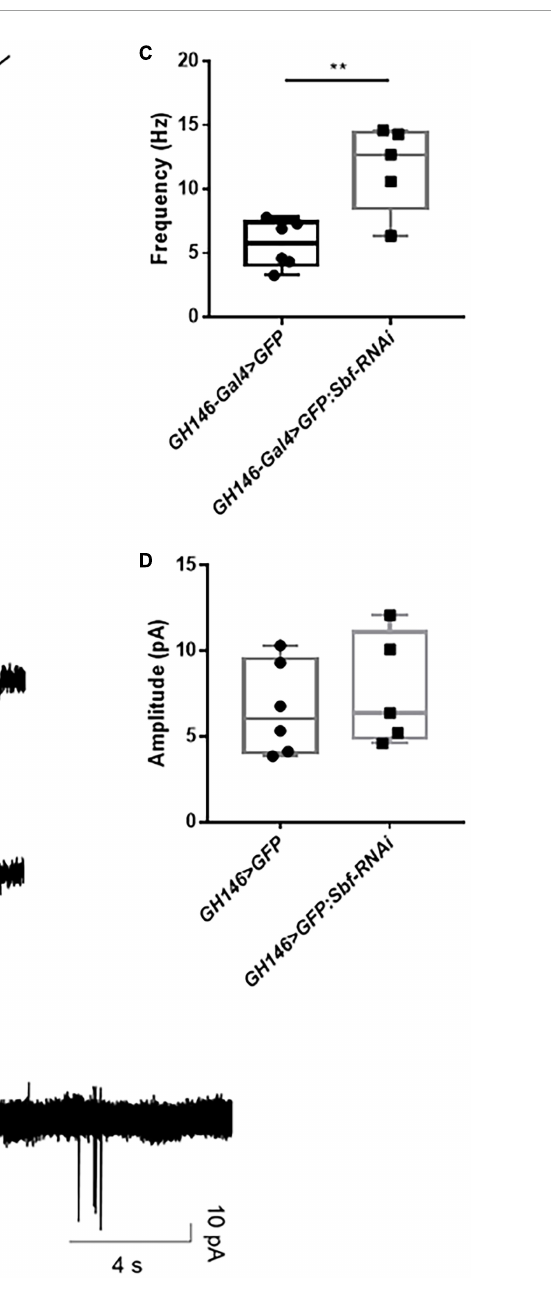
FIGURE5 Whole-cell recording and attached recording in the fly brain. (A) Scheme of whole-cell recording or attached recording in the projection neurons of antennal lobes. Antennal lobes were observed in the anterior view of the brain. Neurons were labeled with GFP, and a recording electrode was used to patch the target neurons. (B) Typical trace of EPSCs in projection neurons of the wild-type flies and Sbf knockdown flies. The frequency of EPSCs in GH146-Gal4 > GFP;Sbf-RNAi flies is higher than that in wild-type files ( GH146-Gal4 > GFP ) (C) , but the amplitude of EPSCs showed no difference between knockdown flies and wild-type flies (D) . (E) Typical trace of action currents in the projection neurons. ** P <